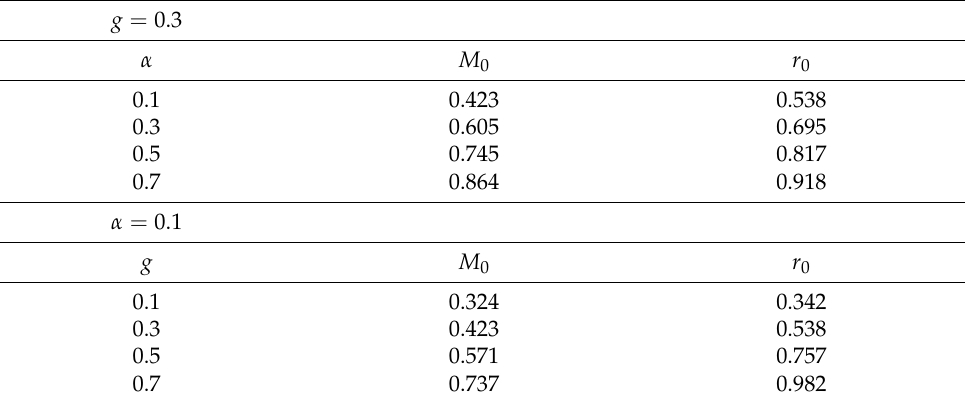
Figure 5. The extremal 4 D nonsingular EGB black holes Metric function f ( r ) vs. r for various values of α and g . Table 3. The remnant radius ( r 0 ) and the remnant mass ( M 0 ) of 4 D nonsingular EGB black hole for different values of ( α ) and g